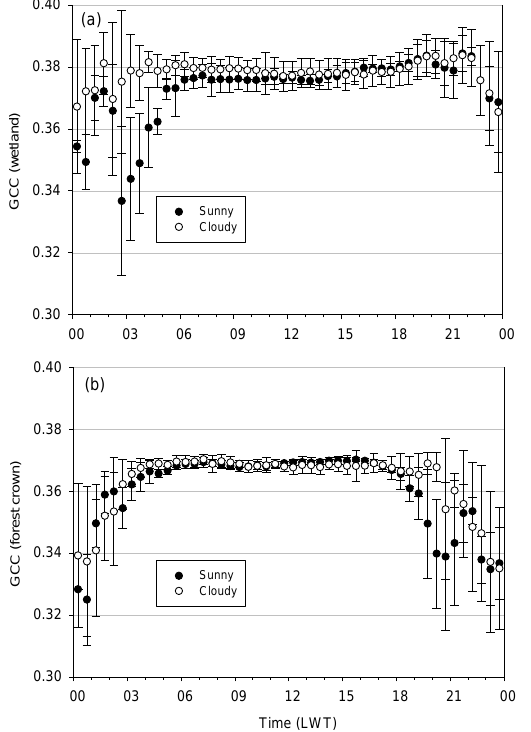
Figure 4. Mean ( ± standard deviation shown by error bars) diurnal cycle of GCC during sunny and cloudy conditions observed with (a) the tree crown and (b) the wetland cameras in July 2014.